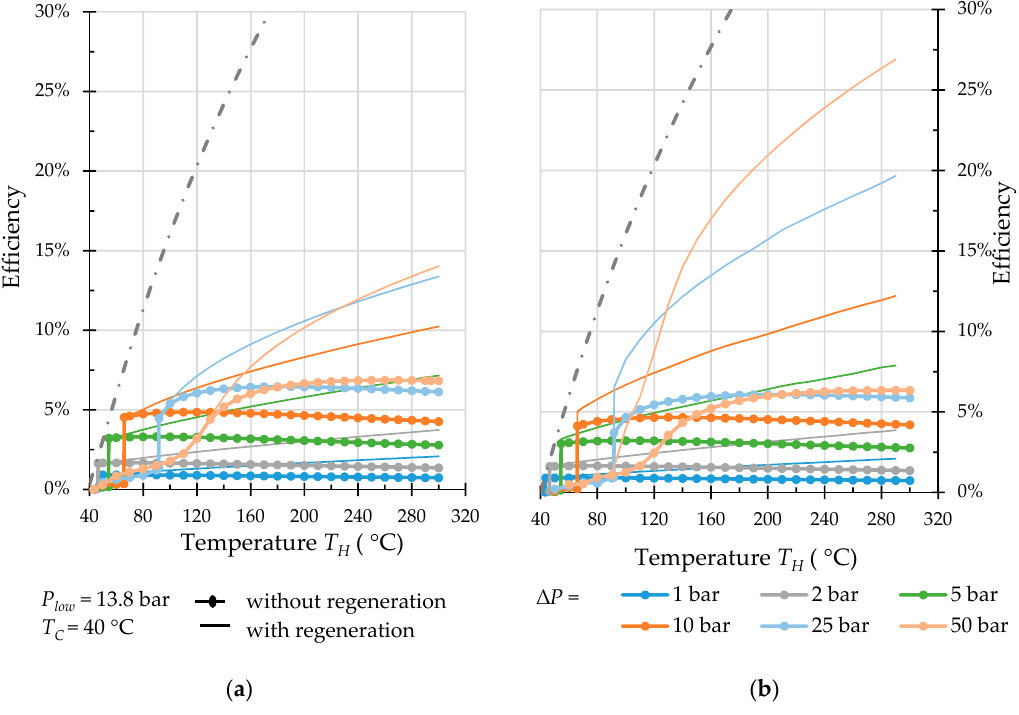
Figure 10. Efficiency of regenerative Worthington-type machine ( a ) and Bush-type machine ( b ) operated with propane.